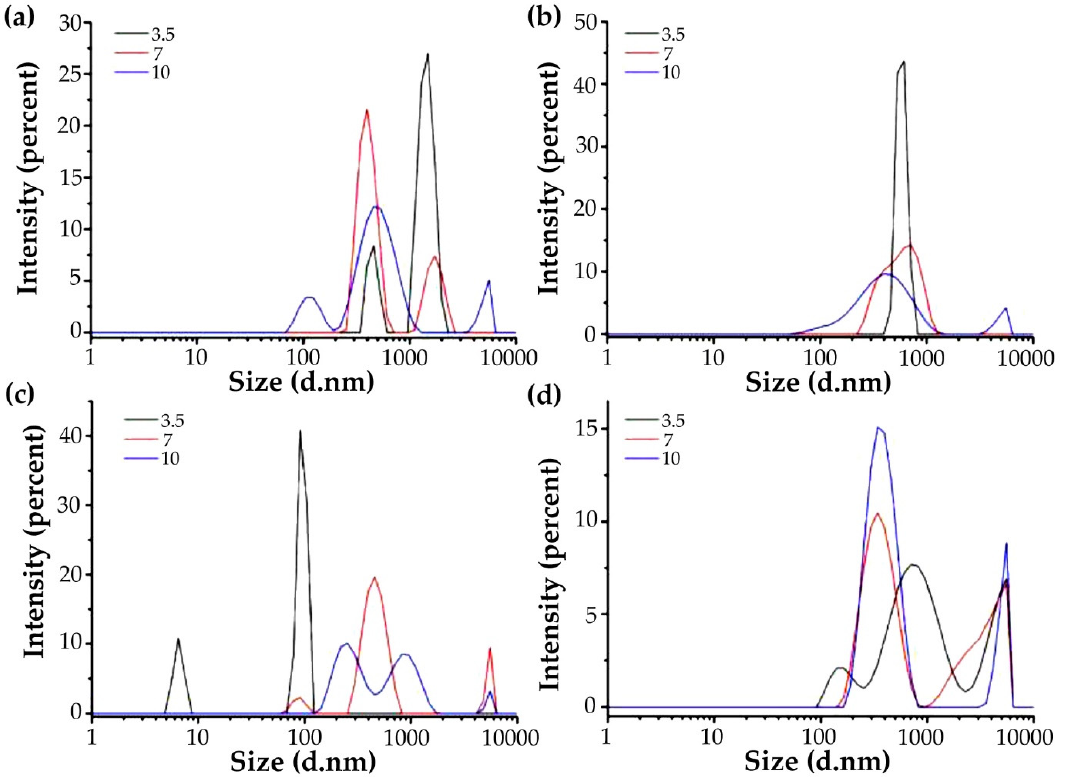
Figure 3. Particle size distribution of G ‐ MLPs at different pHs. ( a ) G ‐ HBSS; ( b ) G ‐ CHSS; ( c ) G ‐ DASS; ( d ) G ‐ CASS. ( d )